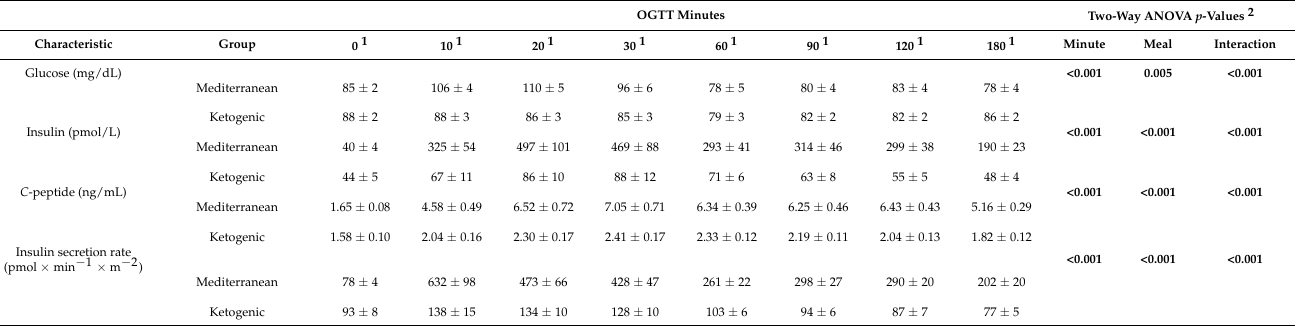
Table 2. Means of OGTT parameters and modeled parameters by OGTT time, and results from two-way ANOVA examining the influence of OGTT time and meal type on each parameter. OGTTMinutes Two-WayANOVA p